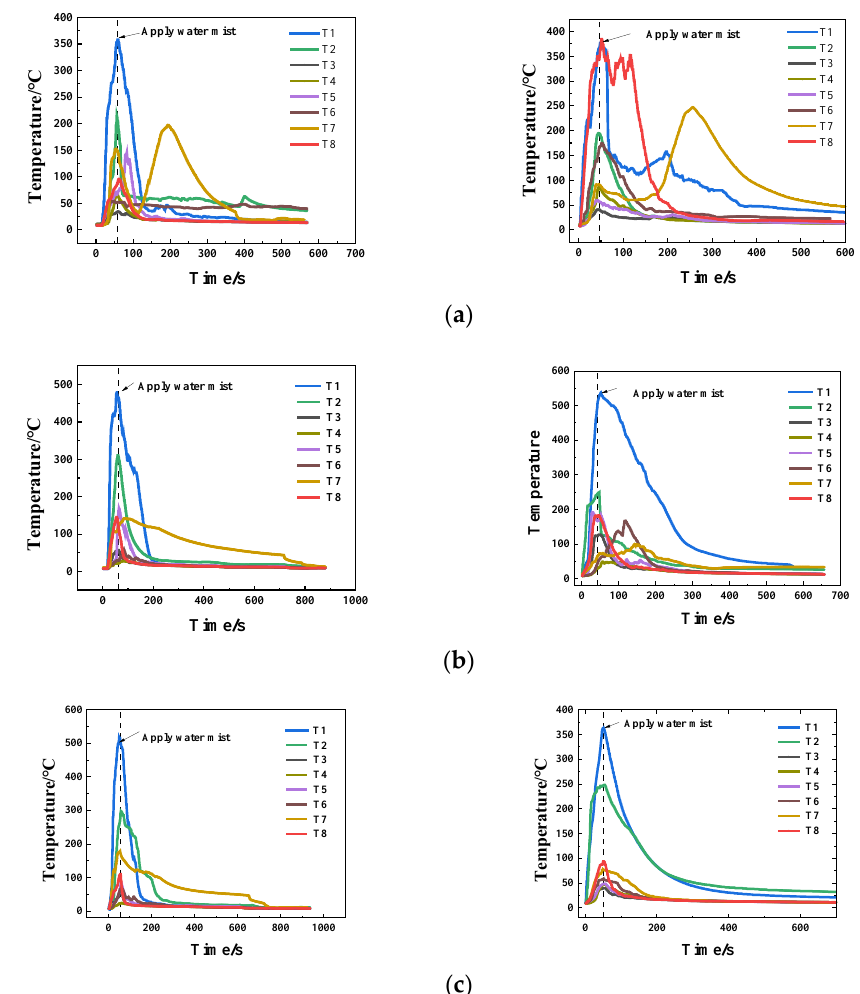
Figure 7. The temperature chart of fire extinguishing under different pressures and different place- ment positions: ( a ) is temperature changes at 1 MPa include horizontal and vertical placement, ( b ) is temperature changes at 3 MPa include horizontal and vertical placement, ( c ) is temperature changes at 9 MPa include horizontal and vertical placement.